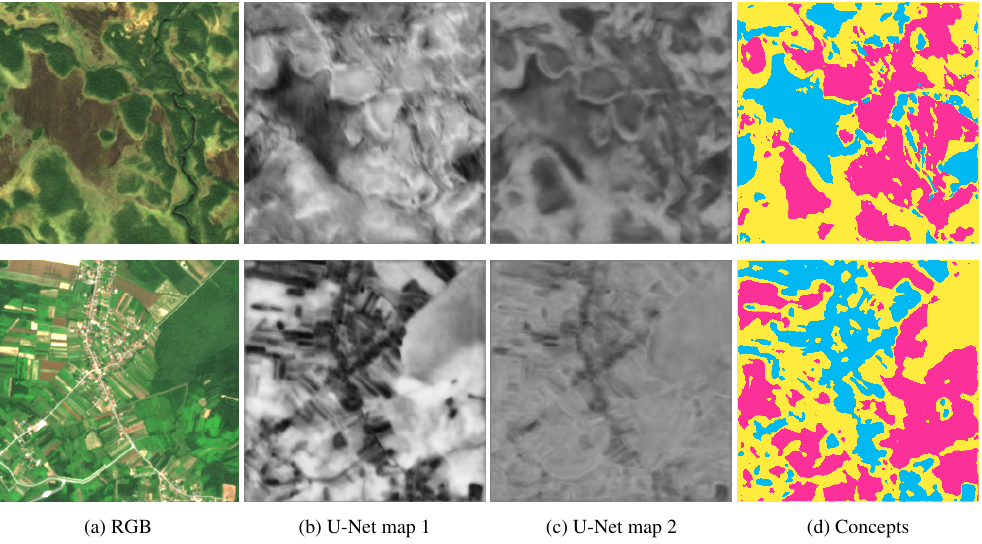
Figure 7. RGB bands, U-Net activation maps, and derived concept segmentations (cyan: water & man-made , magenta: forests , yellow: wasteland ) of two samples (top: wilderness , bottom: non-wilderness ). non-wilderness samples (Fig. 9a) and those on the right hand side show the deviations for wilderness samples (Fig.